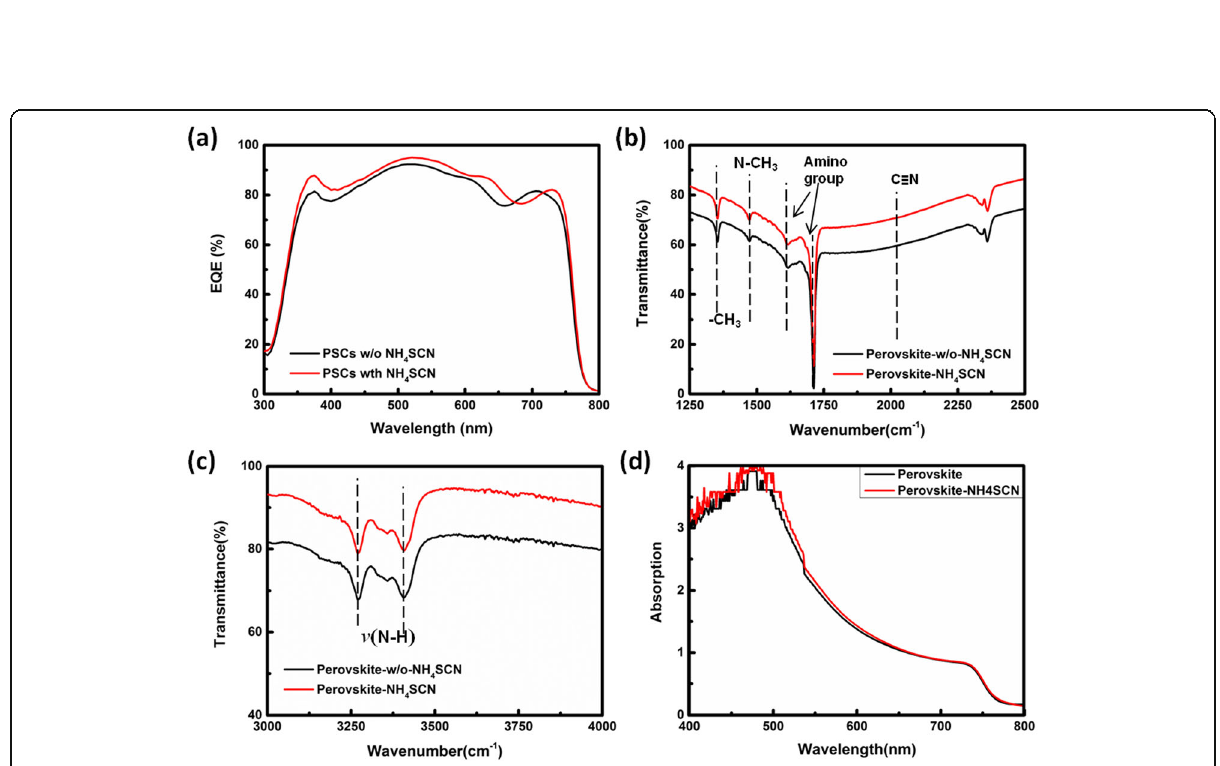
Fig. 2 a – d Statistical data for V OC ( a ), J SC ( b ), FF ( c ), and PCE ( d ) of PSCs based on perovskite films deposited from perovskite precursors doped with different NH 4 SCN